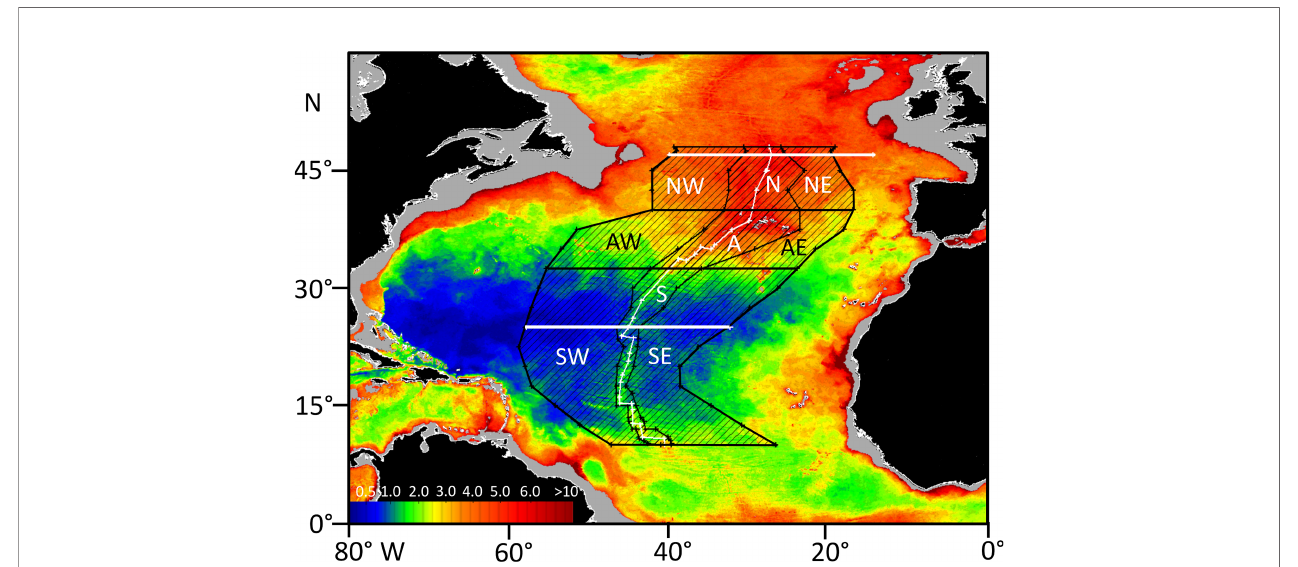
FIGURE 2 | Mean Daily Particulate Organic Carbon Flux (mg C.m -2 .day -1 ) to the sea fl oor in the North Atlantic calculated for October 2002. The three polygons for remote sensing analysis of net primary production (NPP) and particulate organic carbon fl ux (POC), West, MAR and East are shown together with three latitudinal strata, North (NW, N, NE) Azores (AW, A, AE) and South (SW, S, SE). The MAR polygon is de fi ned as the area enclosing lower bathyal depths (3500-800 m depth) on either side of the ridge. The West and East polygon outer boundaries correspond to the deepest points either side of the ridge. The thick white lines are latitudinal transects at 25°N and 47°N. The thin white line is the axis of the